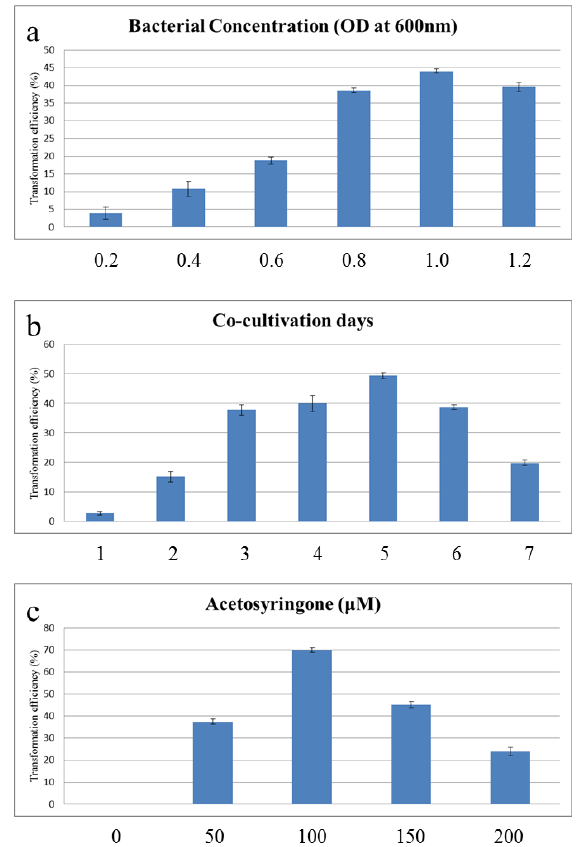
Figure 2. Effect of different parameters of the Agrobacterium transgenic system on transformation of maize callus. ( a ) Effect of bacterial culture density; ( b ) Effect of co-cultivation period; and, ( c ) Effect of acetosyringone concentration.